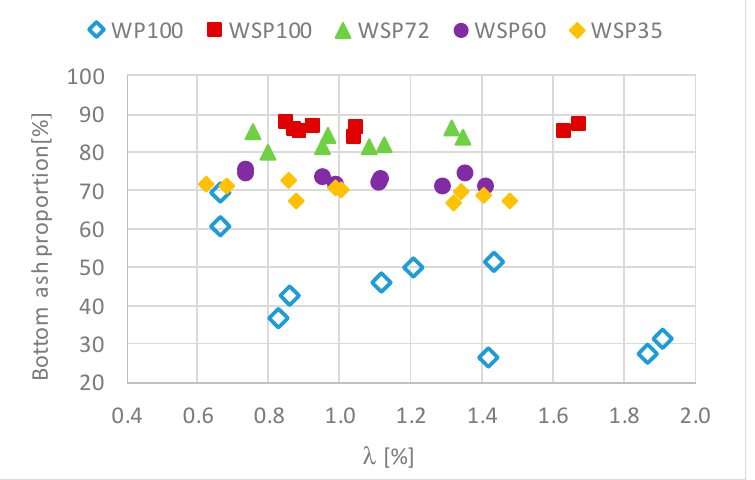
Figure 8. Bottom ash proportion (% with respect to the total amount of ash introduced with the fuel) versus λ for the WP100 and WSP family.